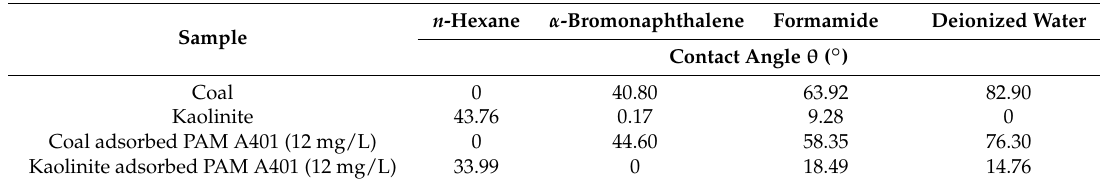
Figure 2. The reproducibility tests for ultra-low ash coal wetted by n -hexane. Table 2. The estimated contact angles.